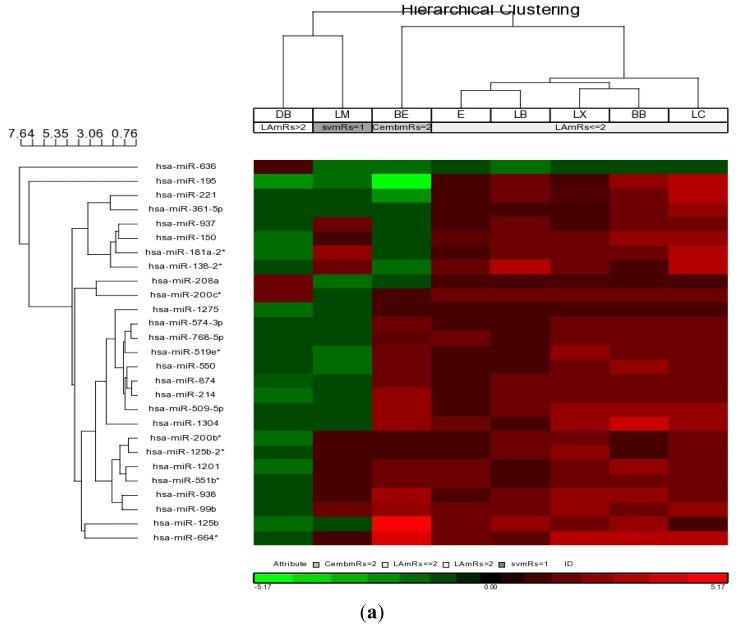
Hierarchical clustering and Principal component analysis (PCA) of low/no risk large artery ischemic stroke patients. (A) miRNA that were differentially expressed among the large artery stroke was analysed. 27 miRNA that showed significant correlation as corrected by FDR (p-value < 0.05) between large artery stroke with mRS ≤ 2 or mRS = 4. Hierarchical clustering was carried out on these miRNA for all the low/no-risk ischemic stroke patients (n = 8). Green rectangle represents down-regulation while red represents up-regulation of miRNA. (B) PCA of large artery ischemic stroke. A radial segregation of large artery stroke samples (BB, DB, E, LB, LC, LX) according to functional outcome (mRS) can be observed.